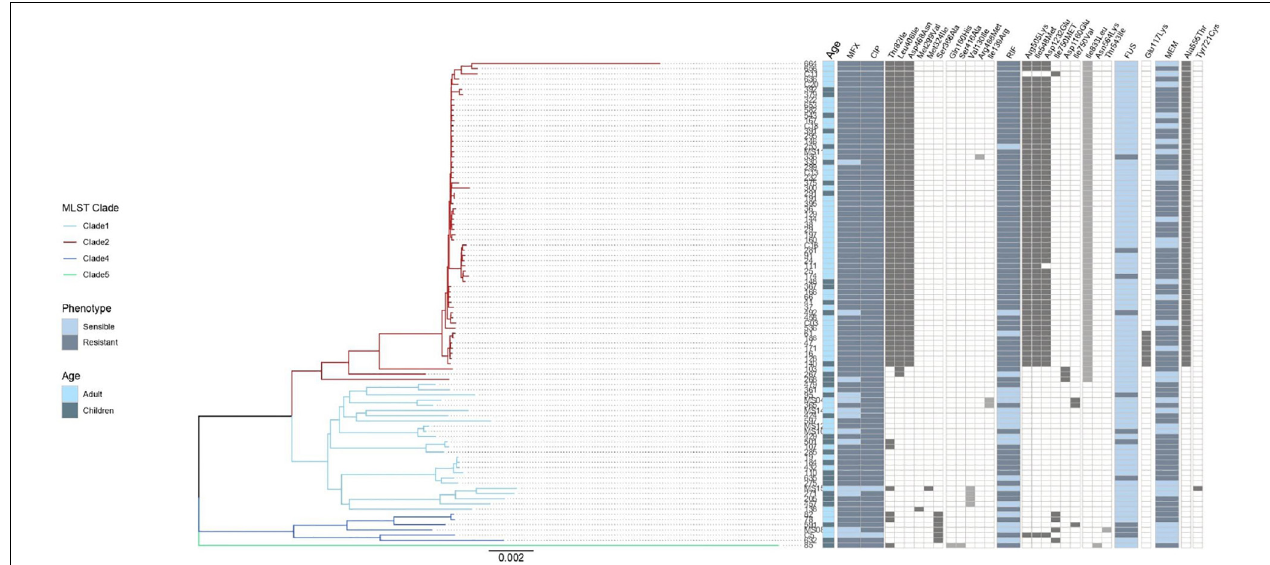
FIGURE 3 | Result of genomic analysis of 94 C. difficile strains from Mexican patients and presence of resistance associated mutations. A phylogenetic tree based on whole genome sequences was constructed using virtual hybridization analysis (VAMPhyRE) and correlated with clades, patient’s age and with the presence of antibiotic resistance mutations. Presence of mutations is indicated by gray rectangles and absence by white rectangles. The sensitive and resistant phenotype are denoted by gray or blue rectangles, respectively, MFX (Moxifloxacin), CIP (Ciprofloxacin), RIF (Rifampicin) FUS (Fusidic acid), MEM (Meropenem). The presence and absence of mutations are denoted by black and white rectangles, respectively.